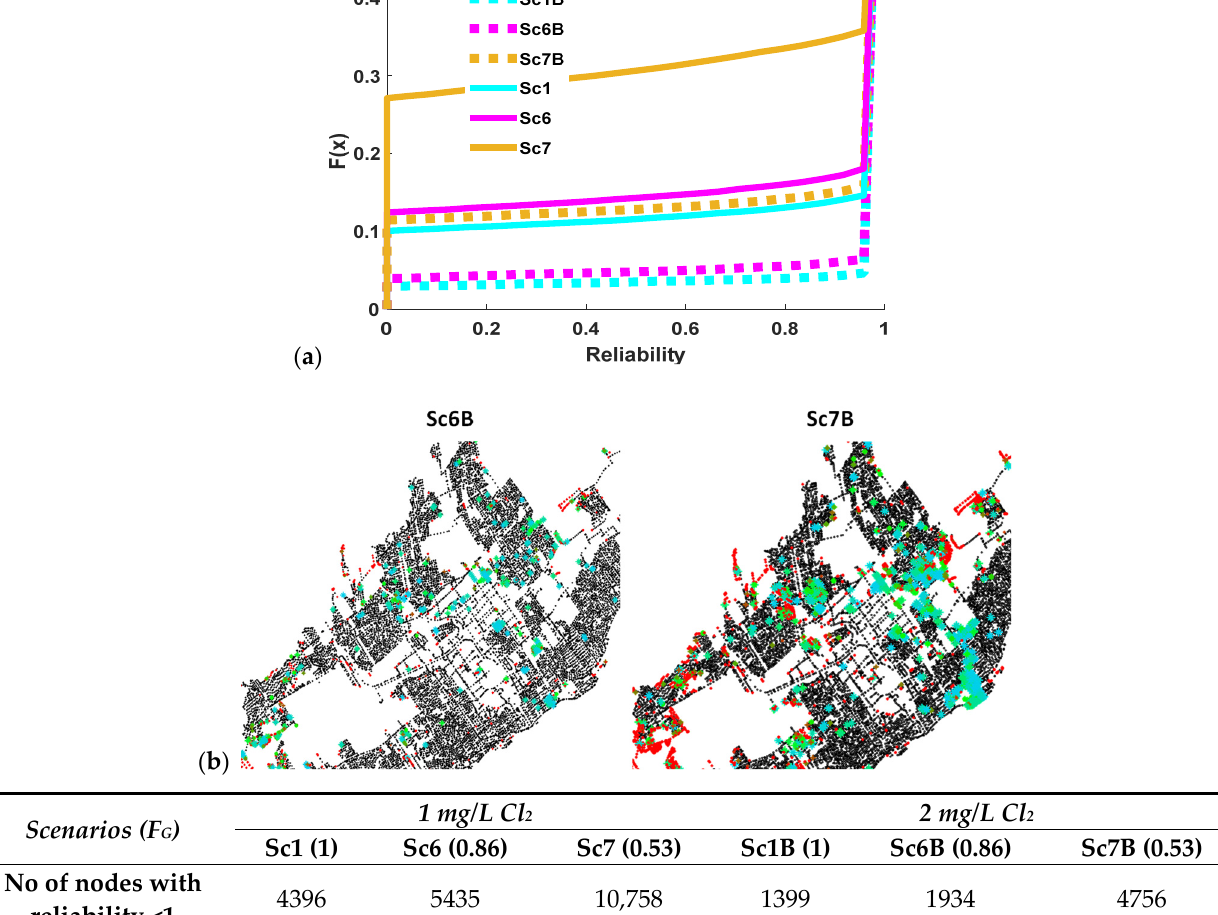
Figure 5. ( a ) Probability that the chlorine reliability will be ≤ x for different water conservation scenarios considering all nodes, Y -axis is cut at 0.4 for better visualization. ( b ) Spatial distribution of nodal chlorine reliabilities of less than one in Sc6B and Sc7B (same color legend as in Figure 4). The number of nodes with a chlorine reliability <1 is indicated in the table.